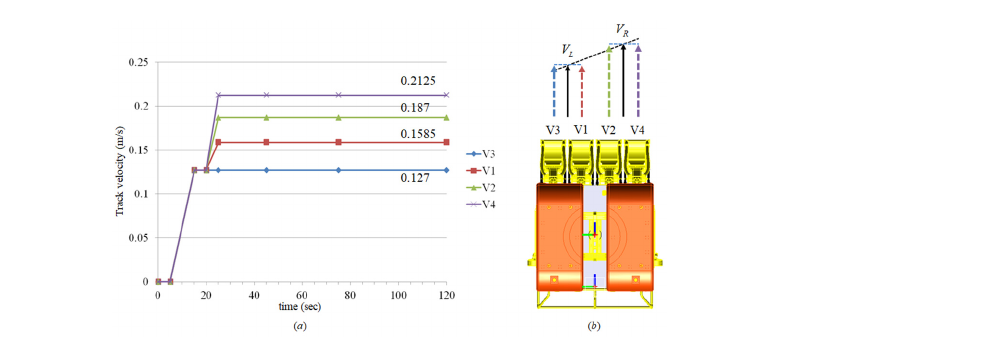
Figure 27. Track input speed and steering ratio of a mining robot for steering driving: ( a ) input speed of each track row, ( b ) definition of track row ID and steering ratio calculation method (Top view of mining robot). Minerals 2022 , 12 , x FOR PEER REVIEW